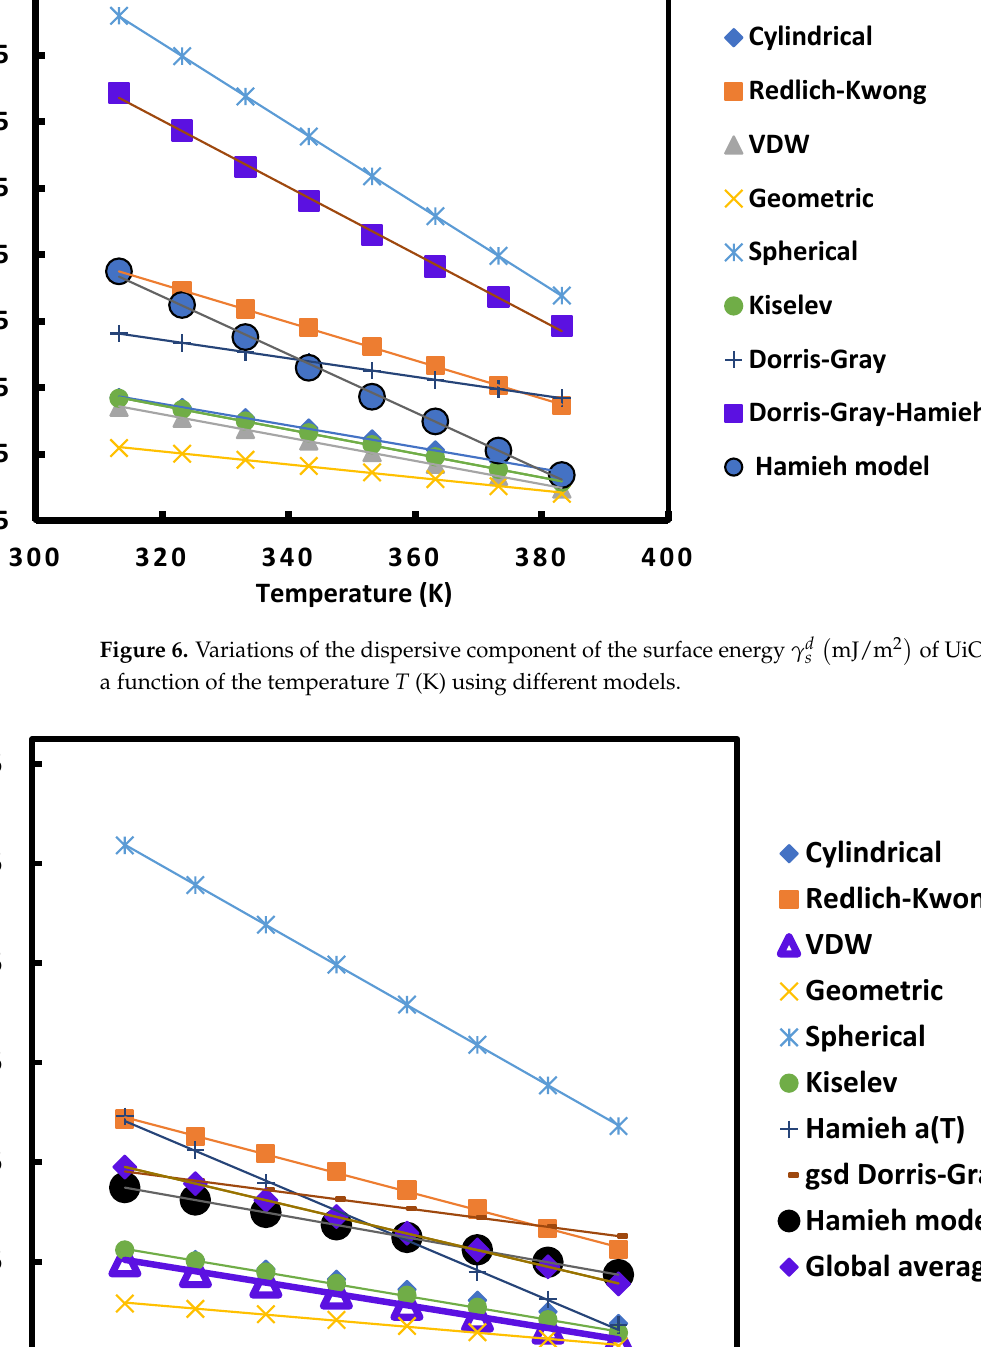
(cid:0) (cid:1) mJ/m 2 of UiO-66-FA as